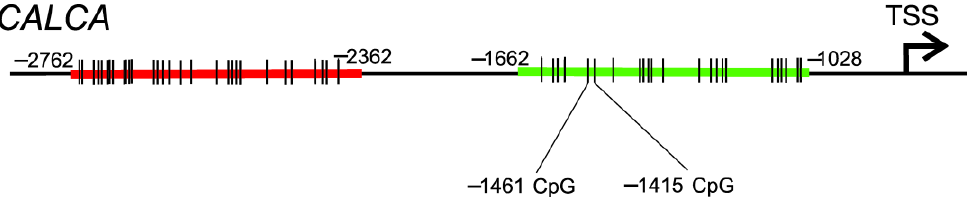
Figure 6. Two CpG islands have been identified in the promoter of the human CALCA (calcitonin- related polypeptide alpha) gene: proximally located between −1028 and −1662 from the transcription start site (TSS) (green) and distally placed between −2362 and −2762 (red). The CpG sites within either island are only symbolically marked by short vertical bars. Positions of two CpG sites located at −1461 and −1415 and recently identified as hypomethylated in migraine patients by Rubino et al. [65] are also presented.